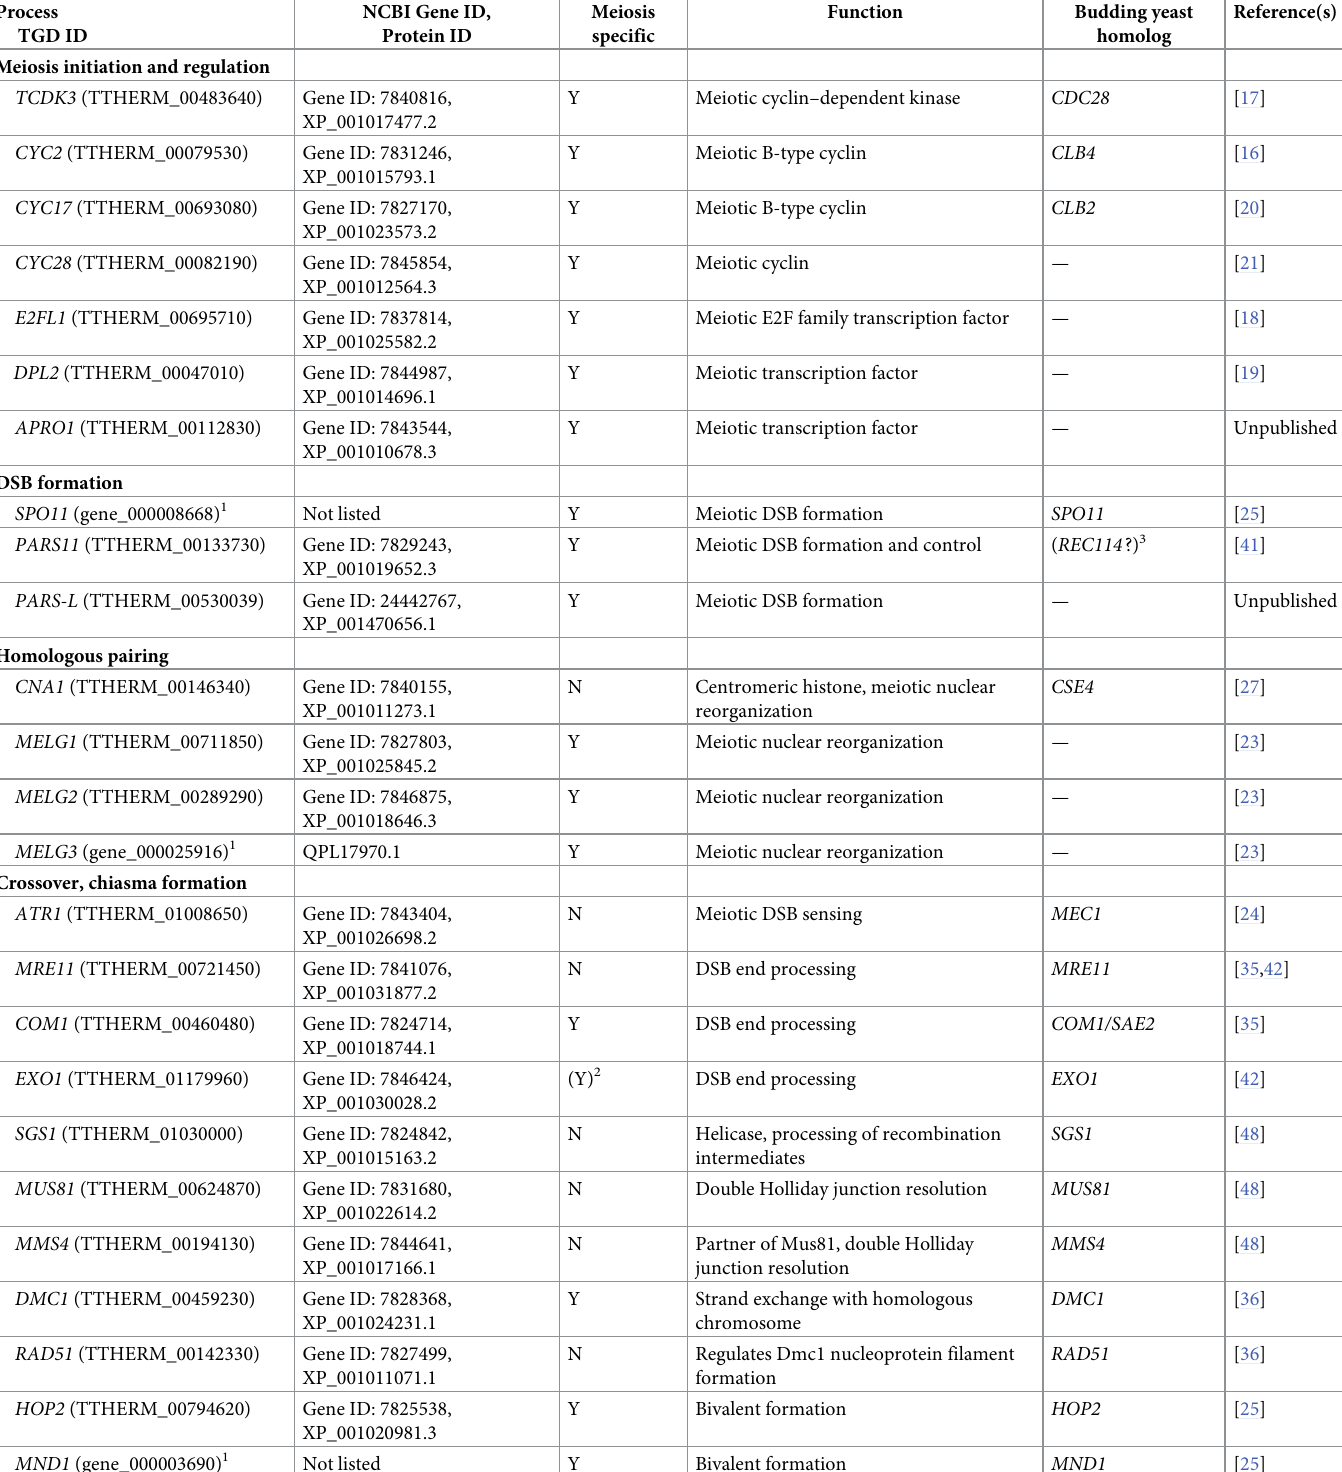
Table 1. Genes with functions in Tetrahymena